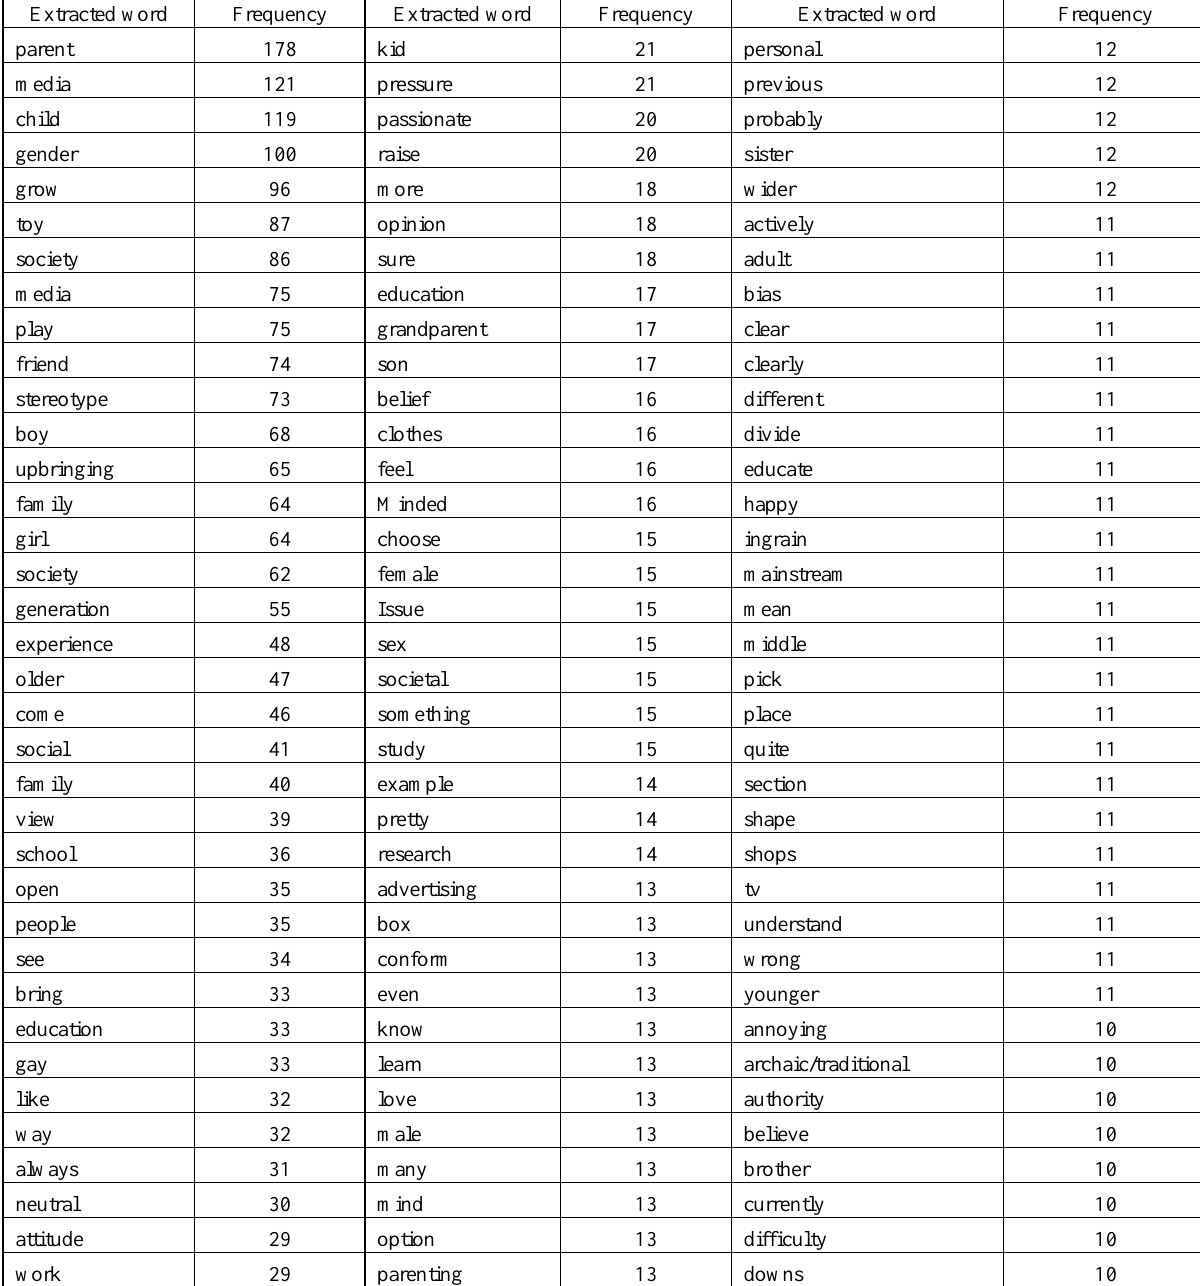
Table 8. List of top words collected from open-ended